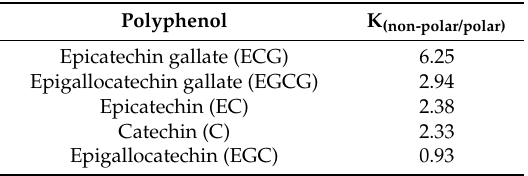
Table 1. Partition coefficients of green tea